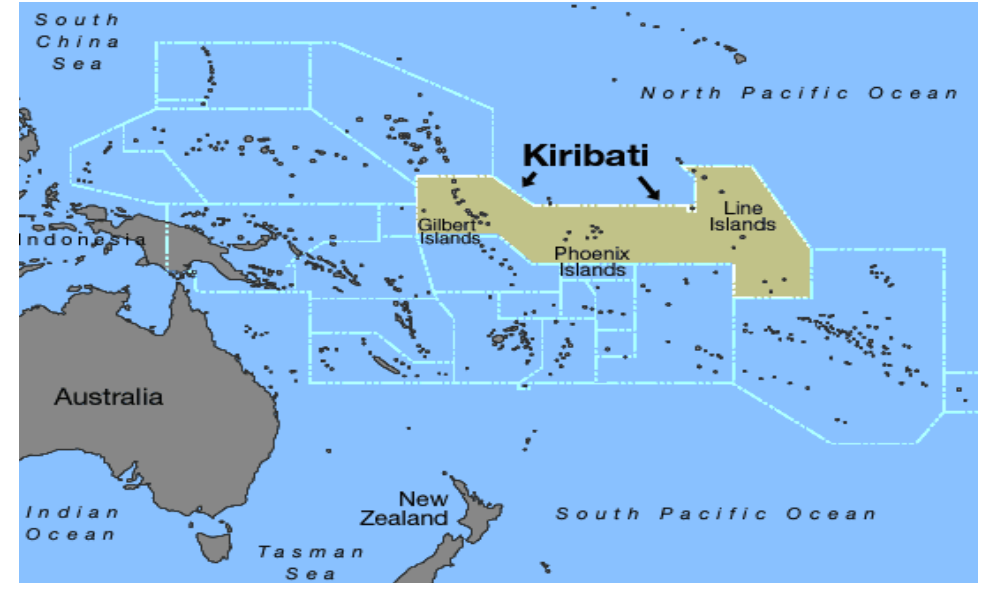
Figure 1. Map of Kiribati (source: Office of Te Beretitenti, Government of